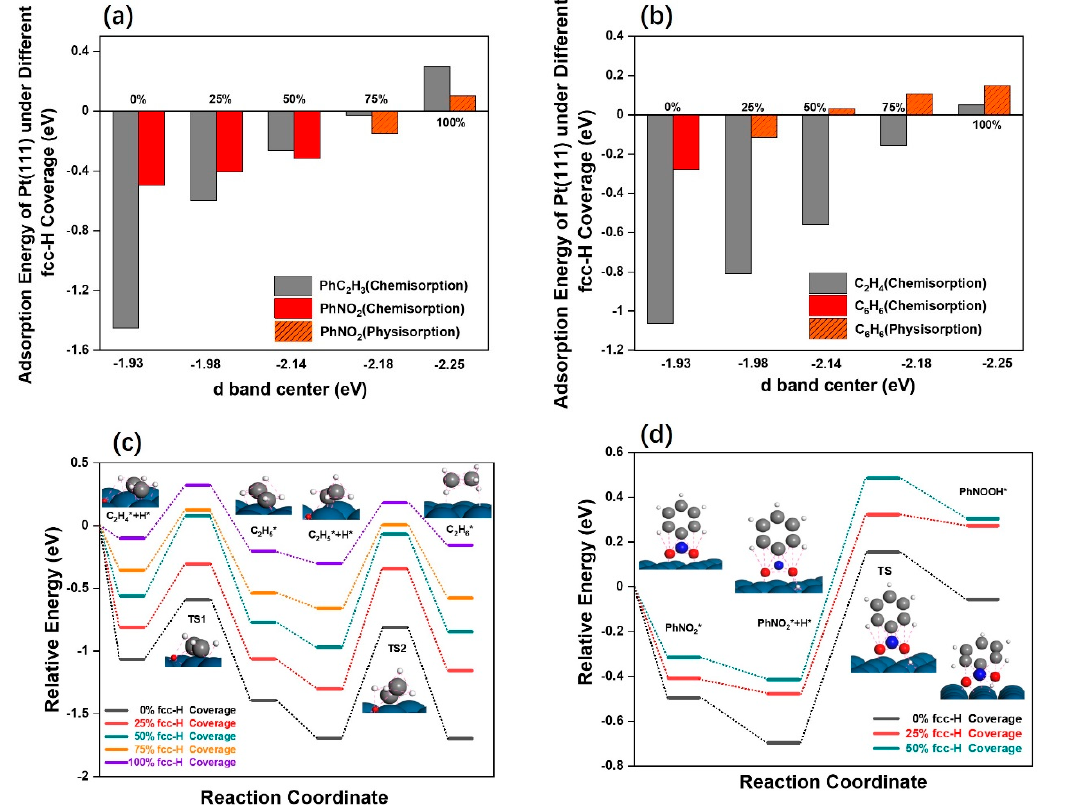
Figure 6. The adsorption energy values of PhNO 2 and PhC 2 H 3 ( a ) and of C 2 H 4 and C 6 H 6 ( b ) on Pt atoms with di ff erent fcc-H coverage rates. ( c ) The reaction path of C 2 H 4 hydrogenation on Pt atoms with different fcc-H coverage rates. ( d ) The first-step hydrogenation reaction path of PhNO 2 on Pt atoms with 0%, 25% and 50% fcc-H coverage.